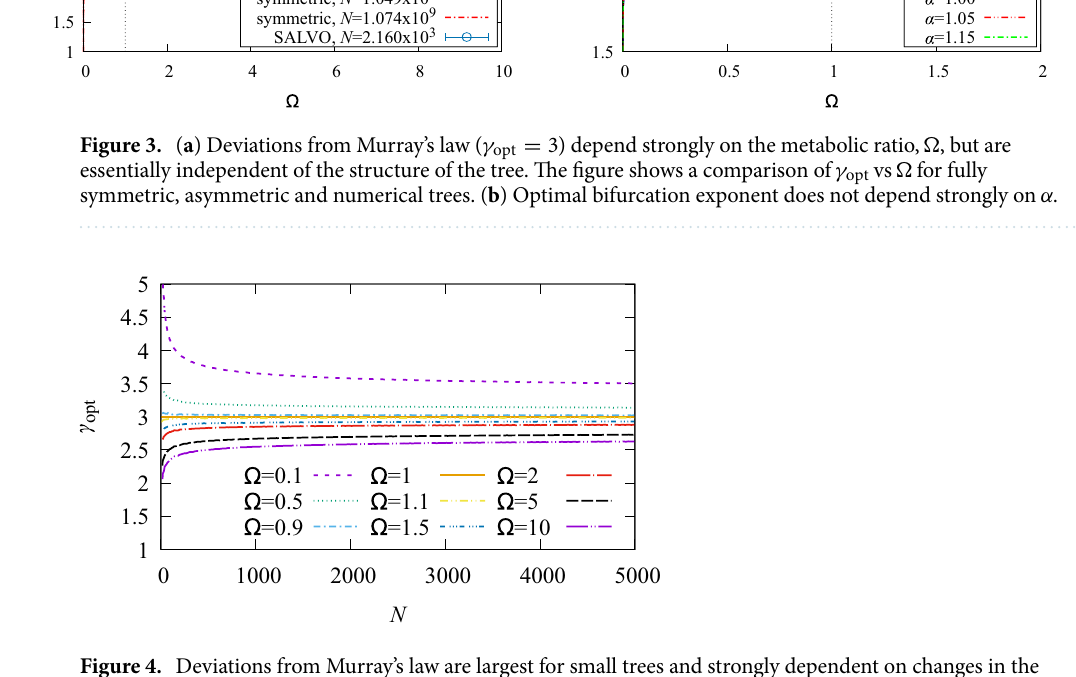
Figure 4. Deviations from Murray’s law are largest for small trees and strongly dependent on changes in the metabolic ratio. The figure shows γ opt vs N for a fully asymmetric